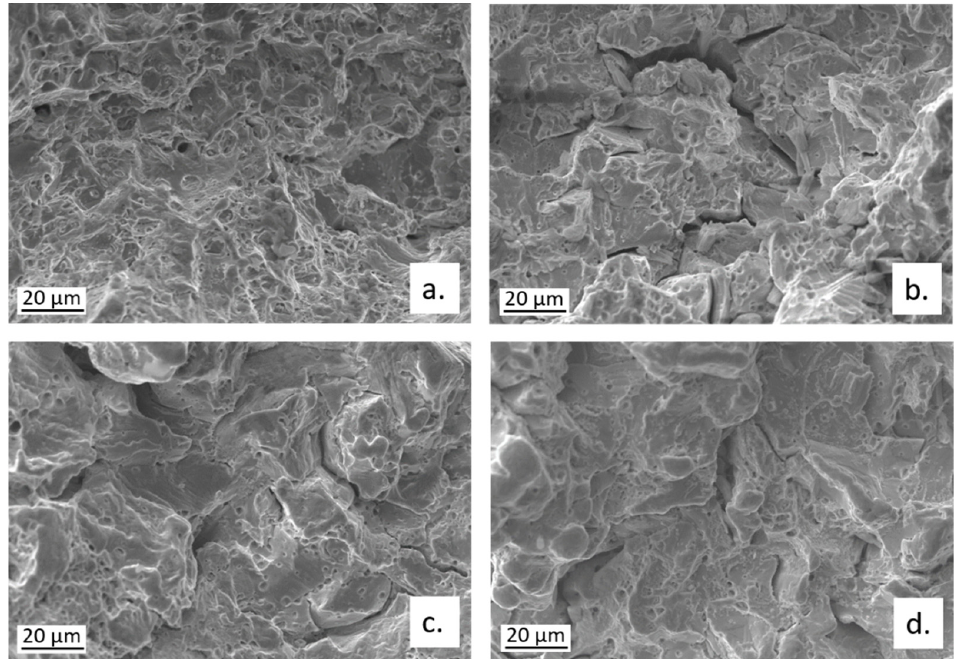
Figure 12. Fractographic analysis of CW617N tensile samples after SSRT carried out in ( a ) air or in SDW solutions containing ( b ) 100 ppm; ( c ) 400 ppm; and ( d ) 700 ppm chlorides.